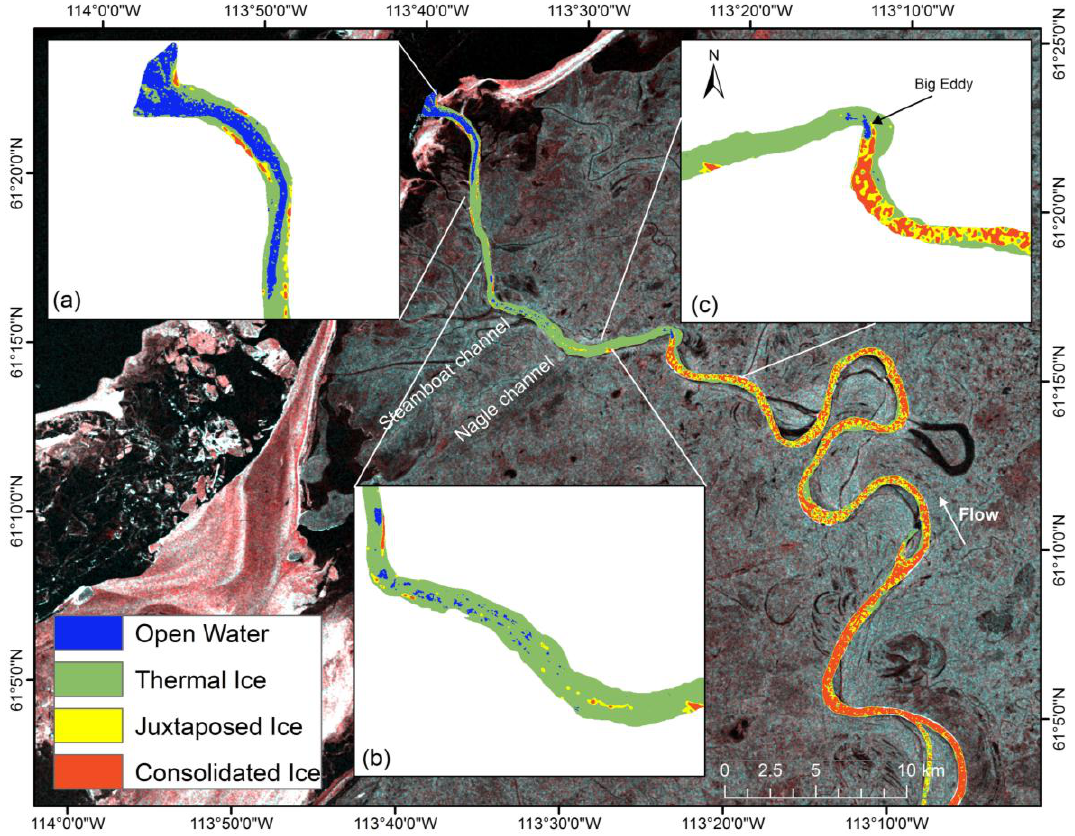
Figure 11. Ice cover on 21 November 2013 in the Slave River Delta channel, ( a ) ice cover in Resdelta Channel, ( b ) ice cover between Nagle Channel and Resdelta Channel, ( c ) ice cover between Jean River and Nagle Channel (RADARSAT-2 Data and Products © MacDonald, Dettwiler and Associates Ltd. (2013)—All Rights Reserved. RADARSAT is an official trademark of the Canadian Space